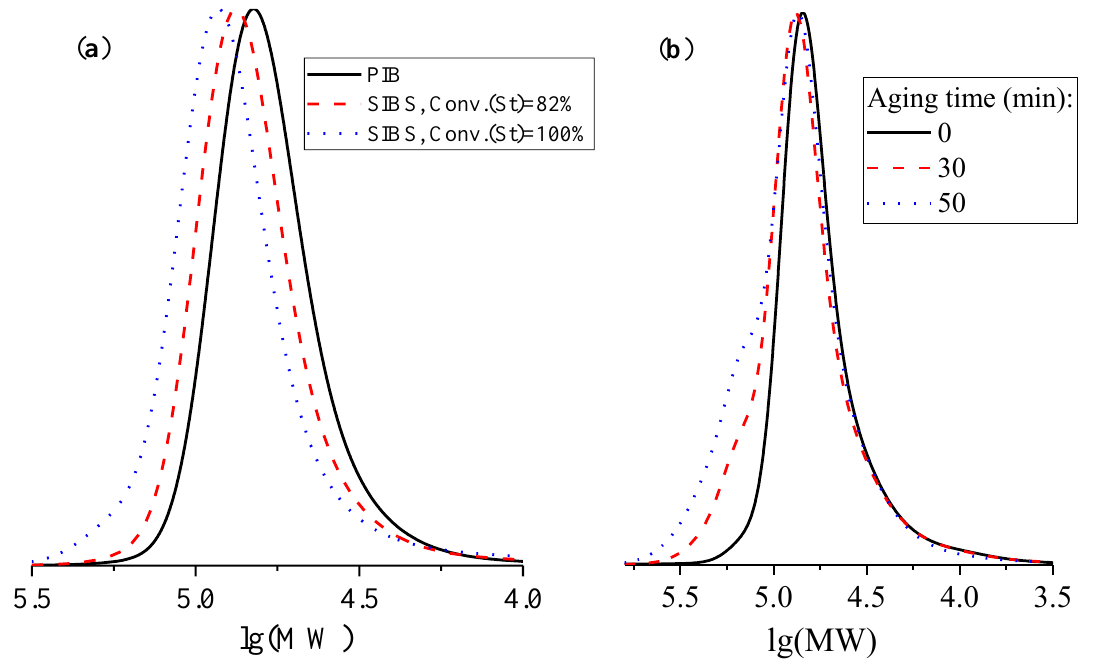
Figure 5. ( a ) SEC traces for the preparation of SIBS at different styrene conversions (run 10, Table 1); ( b ) evolution of SEC traces of SIBS with time at complete monomer conversion.